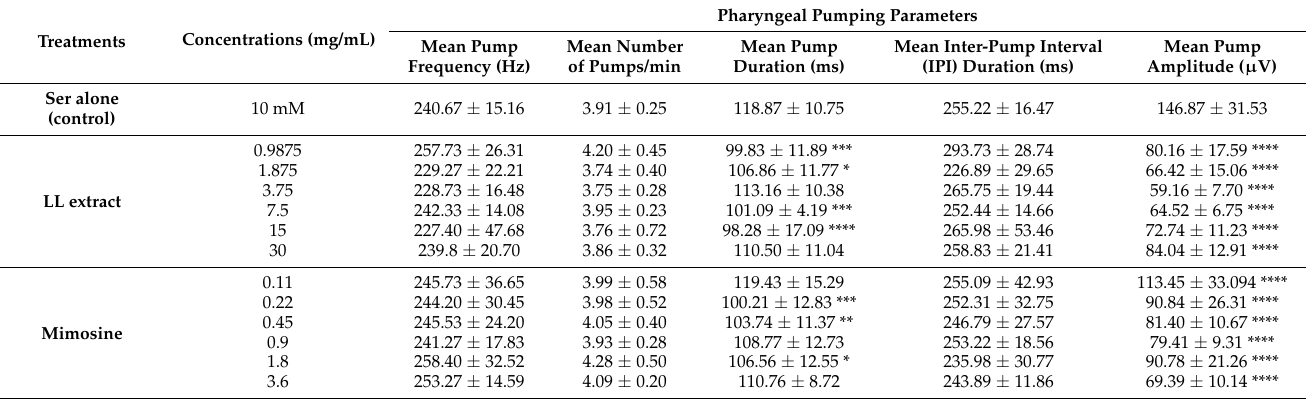
Table 6. Pharyngeal pumping activity of LL extract and